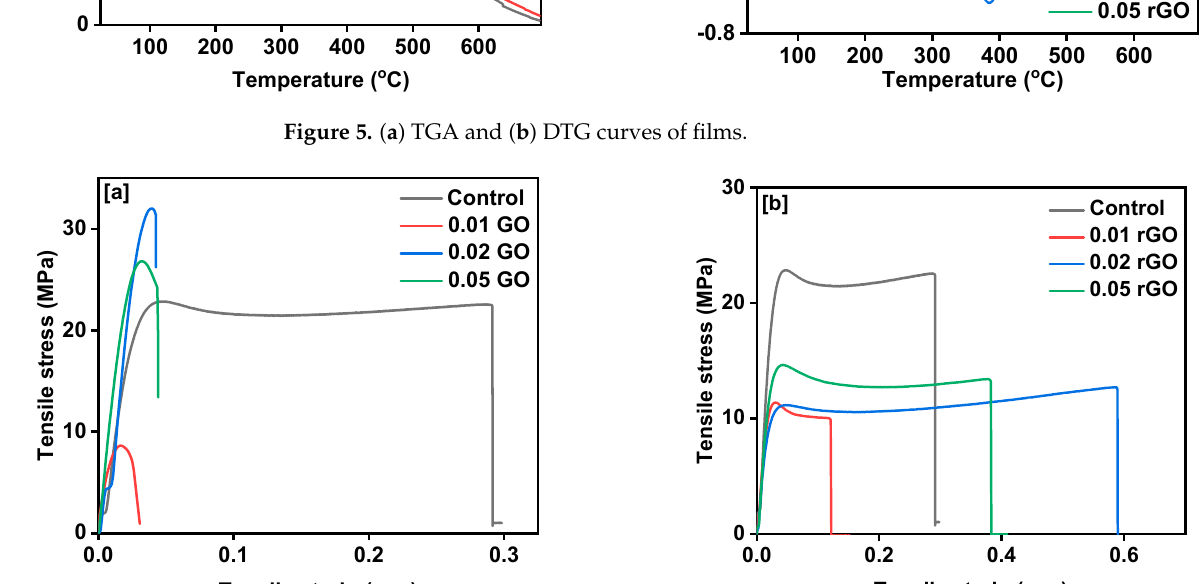
Figure 6. Stress–strain curves of films based on ( a ) GO and ( b ) rGO.